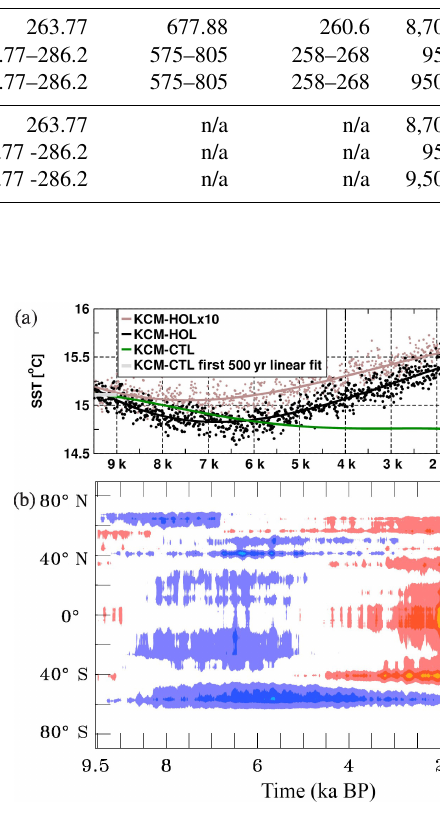
Figure 2. (a) Time series of annual and global mean SST in ◦ C for the three KCM experiments KCM-HOL (non-accelerated forcing, black), KCM-HOLx10 (10 times accelerated forcing, brown), and control experiment KCM-CTL (green). Circles represent annual av- erages (not every year shown), solid lines a fourth-order polynomial fit. The bold grey line indicates a linear fit over the first 500 years of experiment KCM-CTL. (b) Hovmöller diagram of the zonal mean SST anomaly in ◦ C for KCM-HOL, computed by subtracting the average over the first 20 years of KCM-HOL from annual mean values and smoothed by a 10-year running mean. See the colour bar for contour